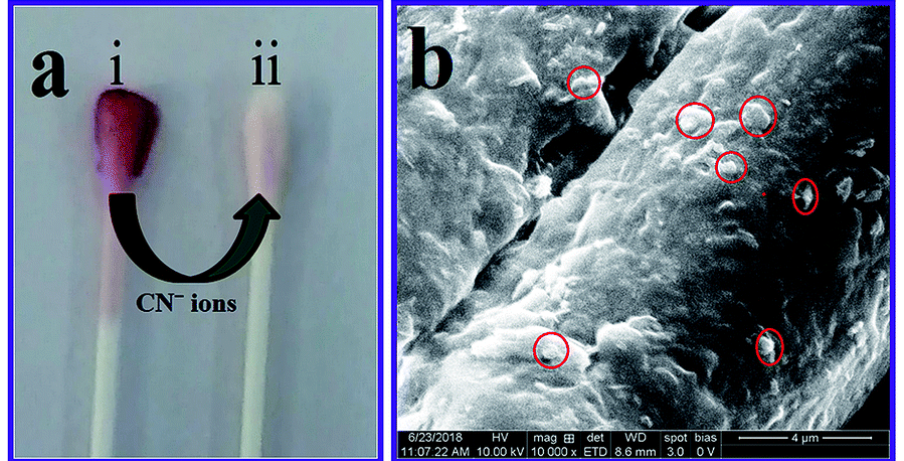
Figure 2. ( a ) β-CD AuNPs coated cotton swab (i), reaction with a concentration of 99 μmol dm −3 of CN − ions changes the color from wine red to colorless (ii), and ( b ) FE-SEM image clearly showing that the AuNPs were embedded in the cotton swab (red circles). Reproduced from Ref. [73] with permission from the Royal Society of Chemistry.